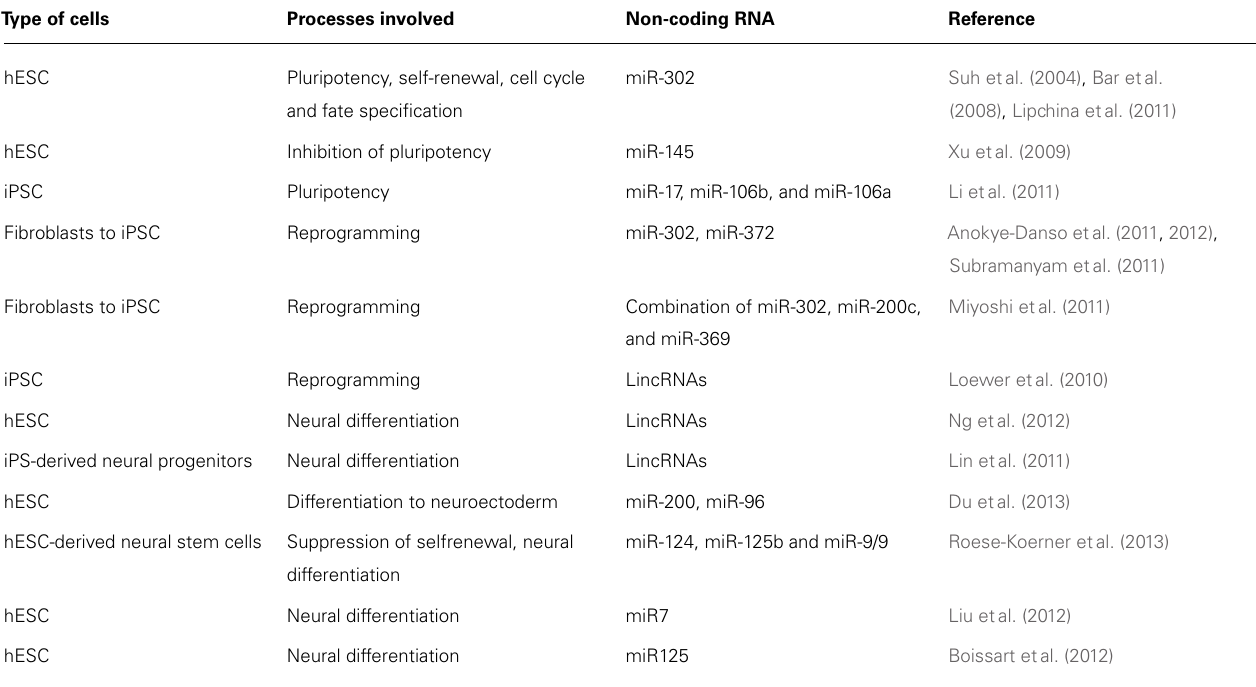
Table 1 | Different roles of non-coding RNA in pluripotency and neural